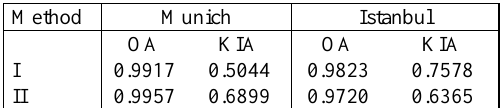
Table 3. Pixel-based change masks evaluation